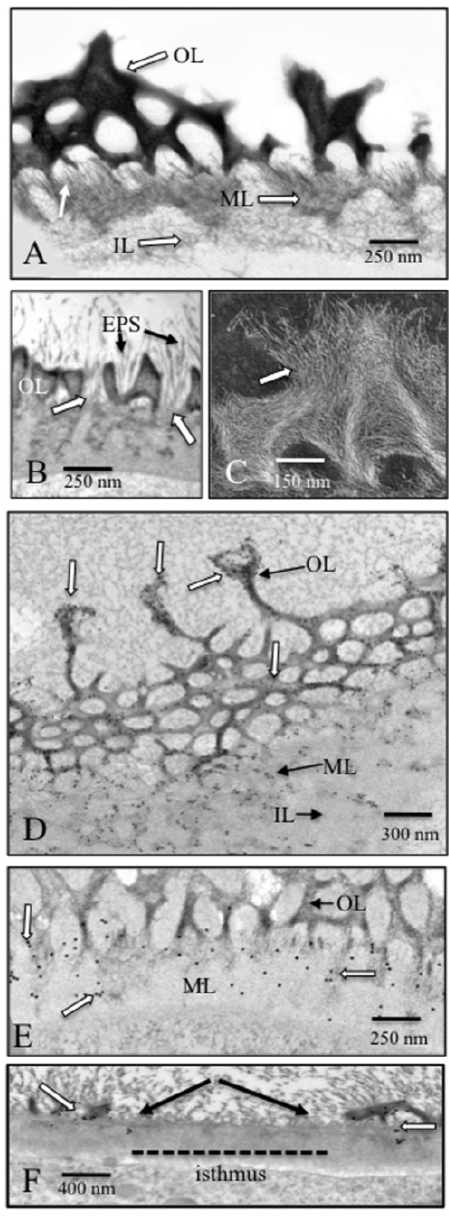
Figure 3. TEM imaging of the cell wall (see [25,27] for details). ( A ) Cross-section of the cell wall highlighting the distinctive outer layer (OL) that forms the lattice, the inner cellulose-based layer (IL) and the interface medial layer (ML). The medial layer is composed of fibrils from the outer layer that embed in the inner cellulose layer; ( B ) EPS fibrils (EPS) attach to the outer surface of the inner/medial wall (white arrows) and extend outward beyond the outer layer (OL); ( C ) Dark field image of the HG fibrils (arrow) that form dense aggregates that make the outer wall layer lattice. This cell was treated with a weak chelator to remove Ca 2+ (see text); ( D ) JIM5 immunogold labeling (white arrows) of the HG-containing outer layer (OL) and medial layer (ML). The inner layer (IL) does not label with this mAb; ( E ) RG-I immunogold labeling (white arrows) of the medial layer (ML), but not the outer layer (OL); ( F ) The isthmus zone labeled with JIM5. Note the absence of the outer lattice in the isthmus (“isthmus”, arrows), but the presence of the lattice on the edges of the isthmus (white